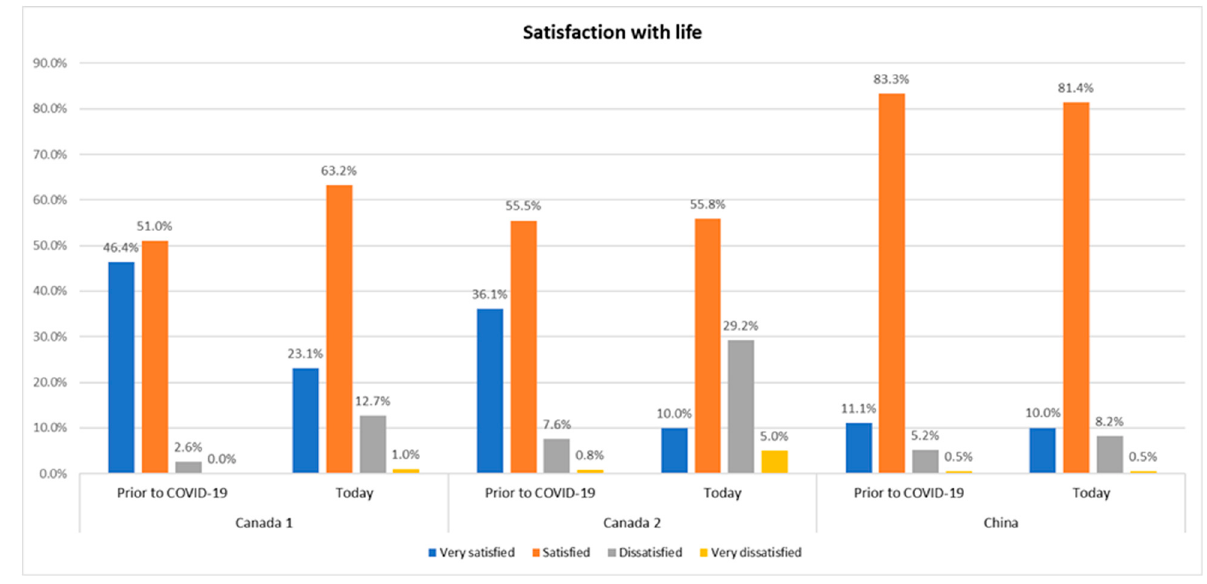
Figure 4. Overall maternal stress level related to COVID-19. * p < 0.001 (between Canada 1/China) and between Canada 2/China. Canada 1 (Can1), n = 1541; Canada 2 (Can2), n = 119; China, n = 448.